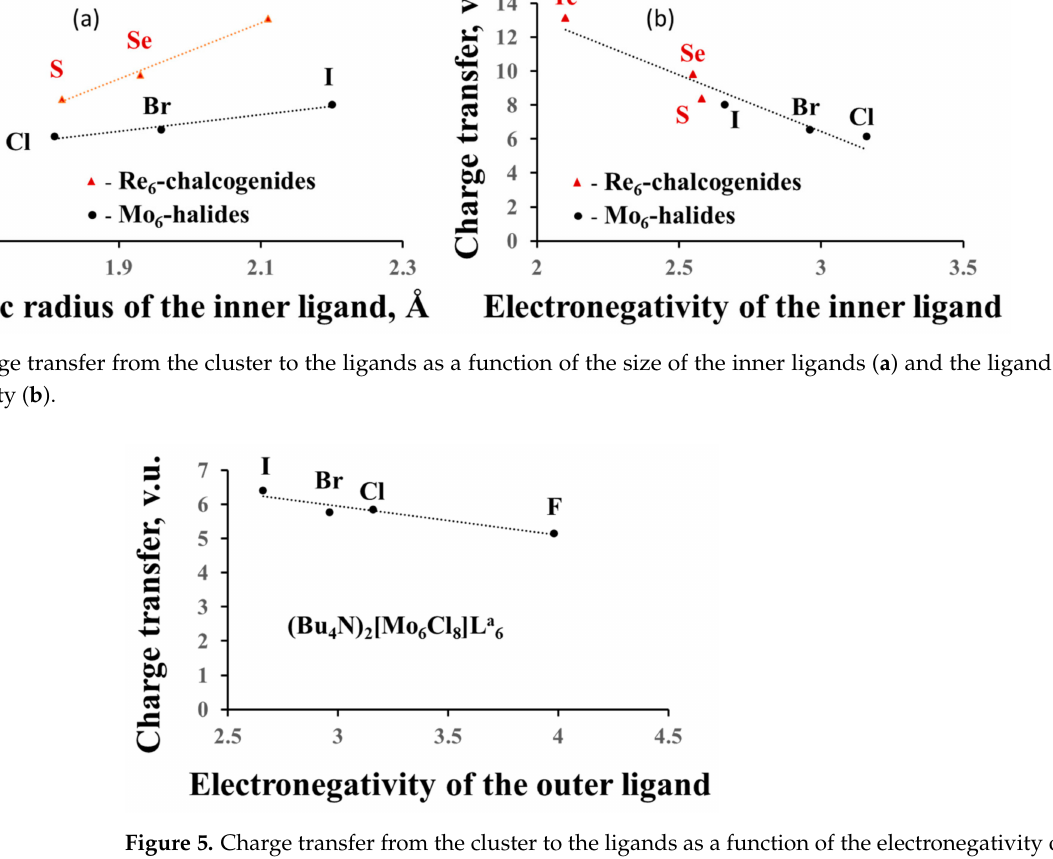
Figure 5. Charge transfer from the cluster to the ligands as a function of the electronegativity of the outer